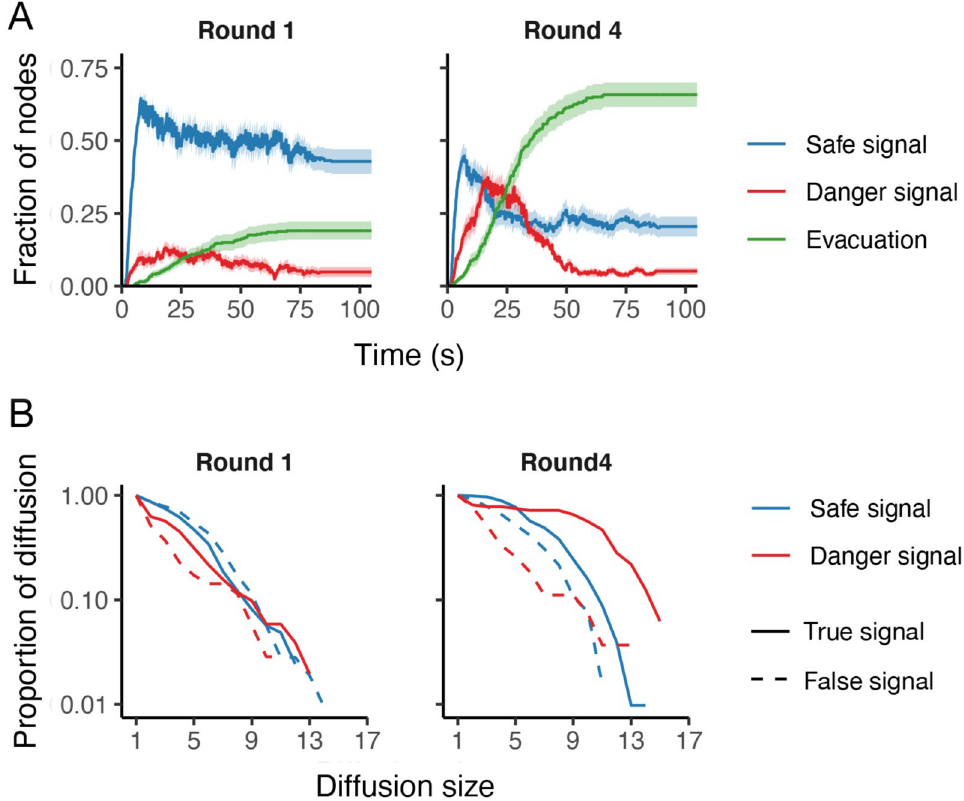
Figure 2. Signal diffusion changes across rounds in dynamic networks. ( A ) Average fraction of nodes showing safe signals (blue lines), danger signals (red lines), and evacuating (green lines) at the first and final rounds in the dynamic network sessions with “disaster” ( n = 20; see Supplementary Fig. 2 for other conditions and rounds). Shading indicates 95% confidence intervals. ( B ) The complementary cumulative distribution functions of diffusions at the first and final rounds in the dynamic network sessions with and without “disaster” ( n = 40) across signal type and accuracy (see Supplementary Fig. 3 for other conditions and rounds). Lines present the proportion of signal diffusions involving equal to or more than the number of players indicated at the x-axis. As for signal accuracy, while there is no detectable difference at round 1 ( P = 0.839; Kolmogorov–Smirnov test),